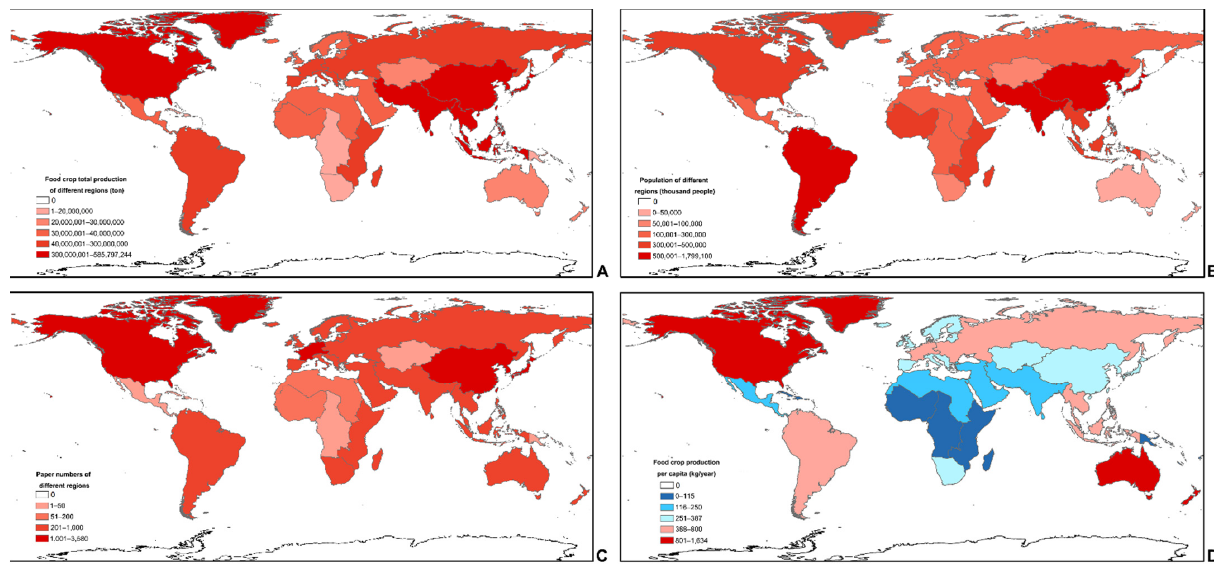
Figure 2. Comparisons on food crop total production ( A ), population ( B ), paper numbers ( C ) and food crop production per capita ( D ) at different continents. The figure ( A – D ) data were collected in 2014, while figure ( C ) was collected from 1900 to 2018. In figure ( D ), the regions in which production per capita was below the world average in 2014 (387 kg) were colored in blue and the one above world average in red.